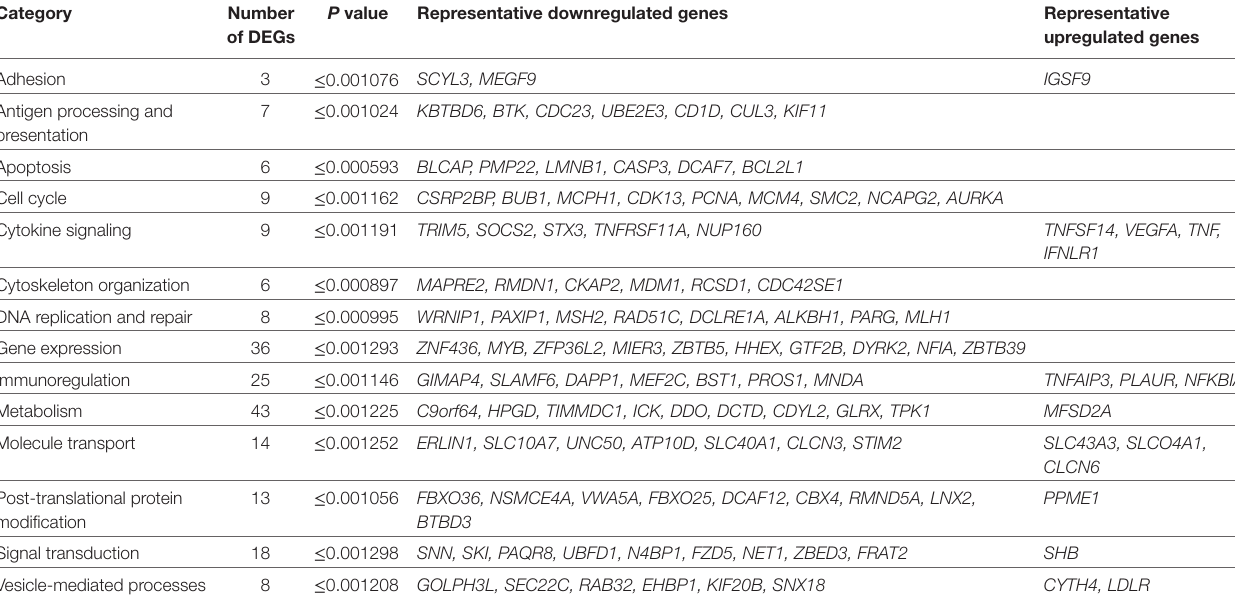
Table 5 | DEGs in dendritic cells (DCs) from patients with type 1 diabetes (T1D) after PSA-liposomes and PSB-liposomes phagocytosis. category number P value representative downregulated genes representative of Degs